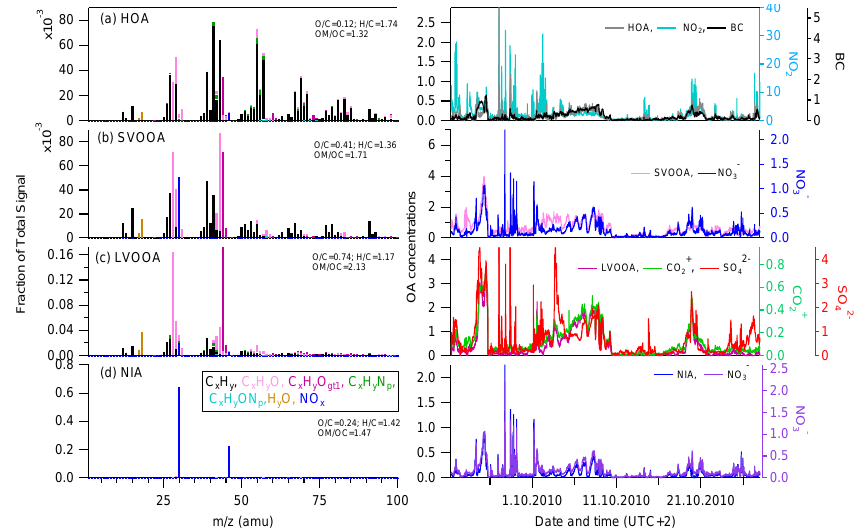
Figure 5. PMF factor solutions to the high-resolution mass spectra: profiles (left panel) and time series and the correlations with the tracers (right panel). All species on the right axis are in units of µgm − 3 .